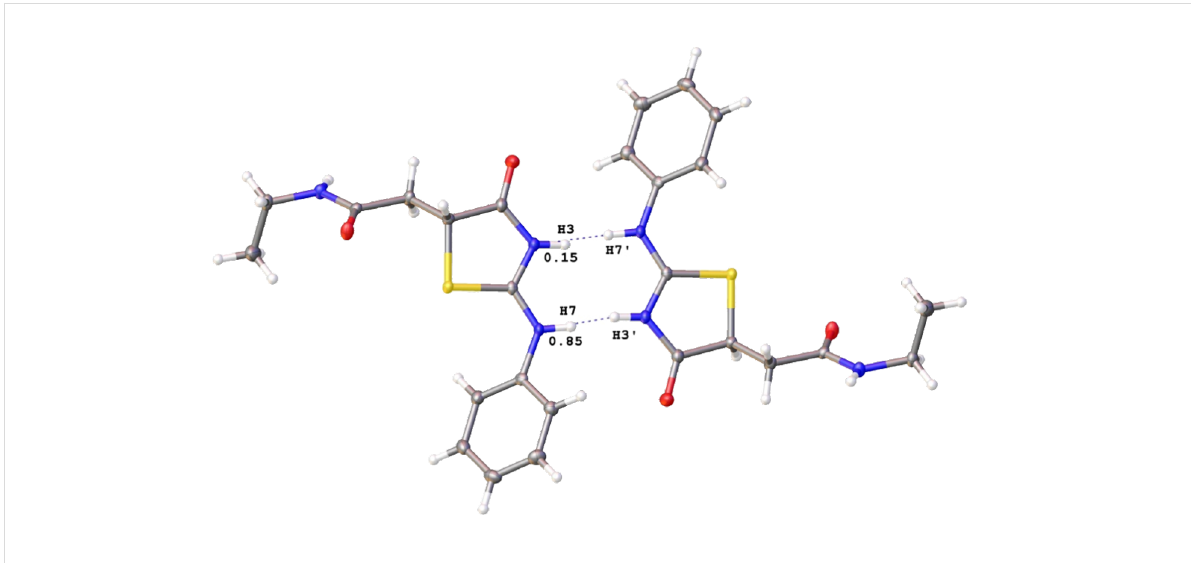
Figure 1: OLEX2 representation of the crystal structure of thiazolidine 3b . Thermal ellipsoids are given at the 50% probability